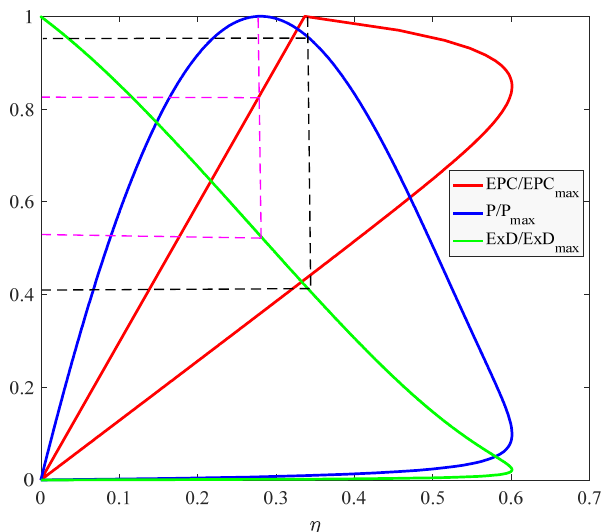
Figure 3. Relationship between efficiency and dimensionless 𝐸𝑃𝐶, 𝑃, 𝐸𝑥𝐷 .